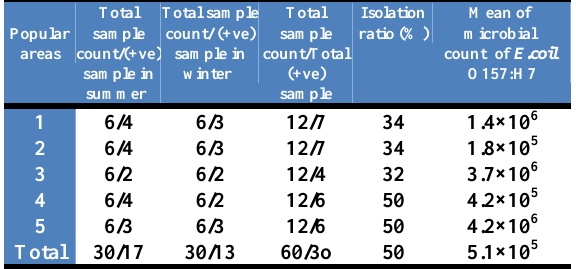
Table, 2: Isolation ratio and the rate of bacterial count of E.coli O157:H7/g in stores popular areas.